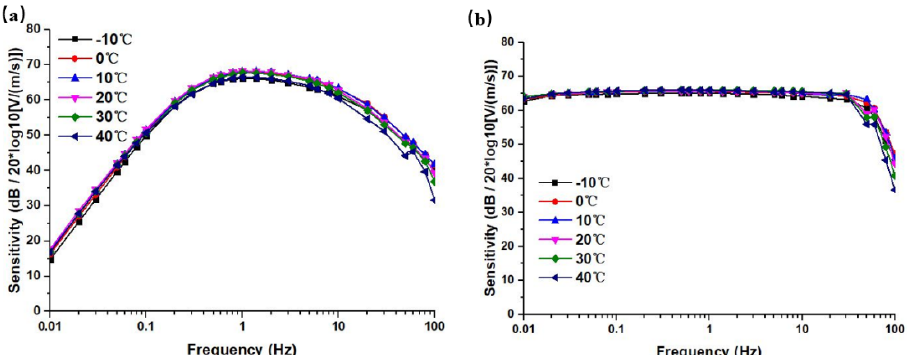
Figure 11. ( a ) Test results for open-loop sensitivity curves after temperature compensation. ( b ) Test results for closed-loop sensitivity curves after temperature compensation.